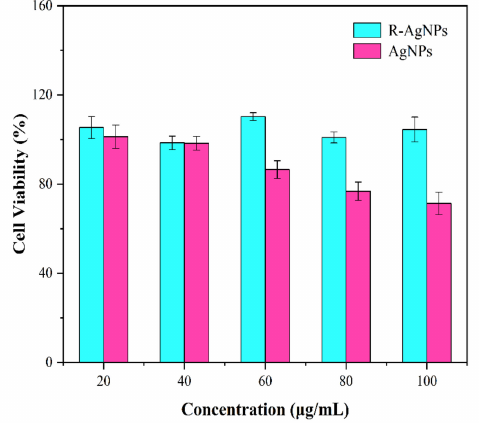
Figure 11. Cell viability of 3T3 cells in different concentrations of R-AgNPs and